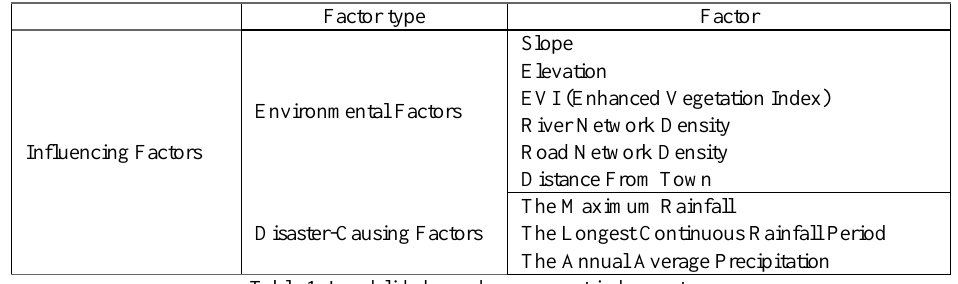
Table 1. Landslide hazard assessment index system